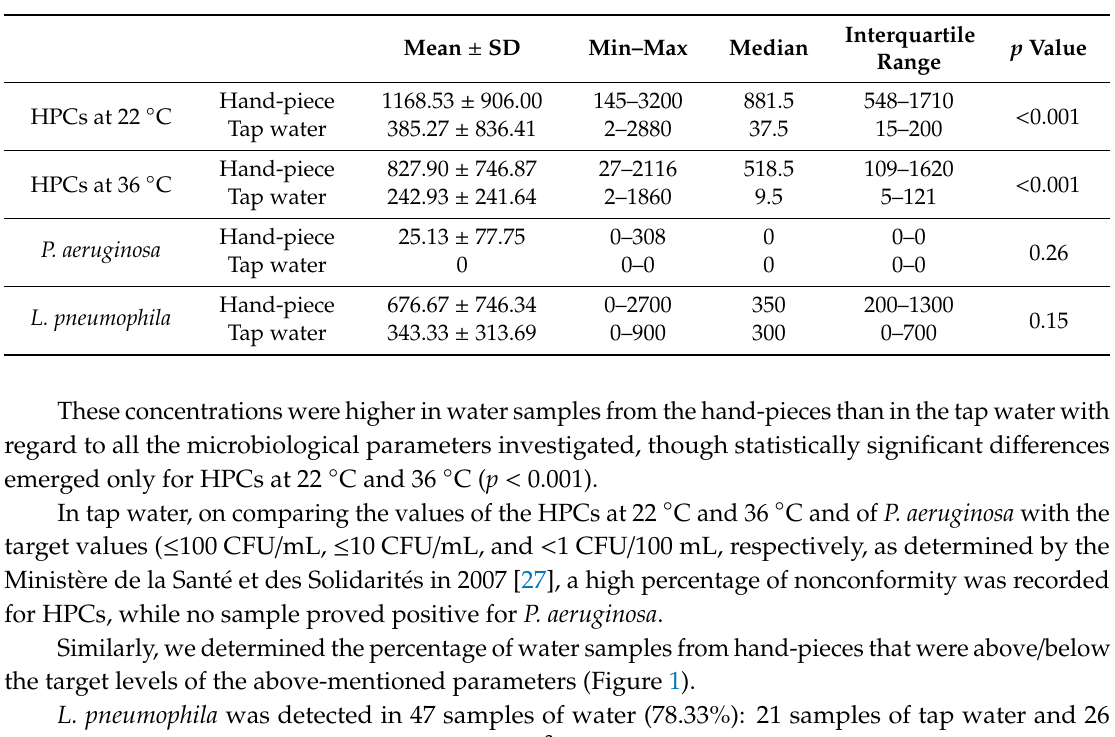
Table 1. Concentrations of heterotrophic plate counts (HPCs) at 22 ◦ C and 36 ◦ C (colony-forming units (CFU) / mL), L. pneumophila (CFU / L) and P. aeruginosa (CFU / 100 mL) in water from hand-pieces and tap water. Mean ± SD Min–Max Median Hand-piece 1168.53 ± 906.00 HPCs at 22 ◦ C Hand-piece